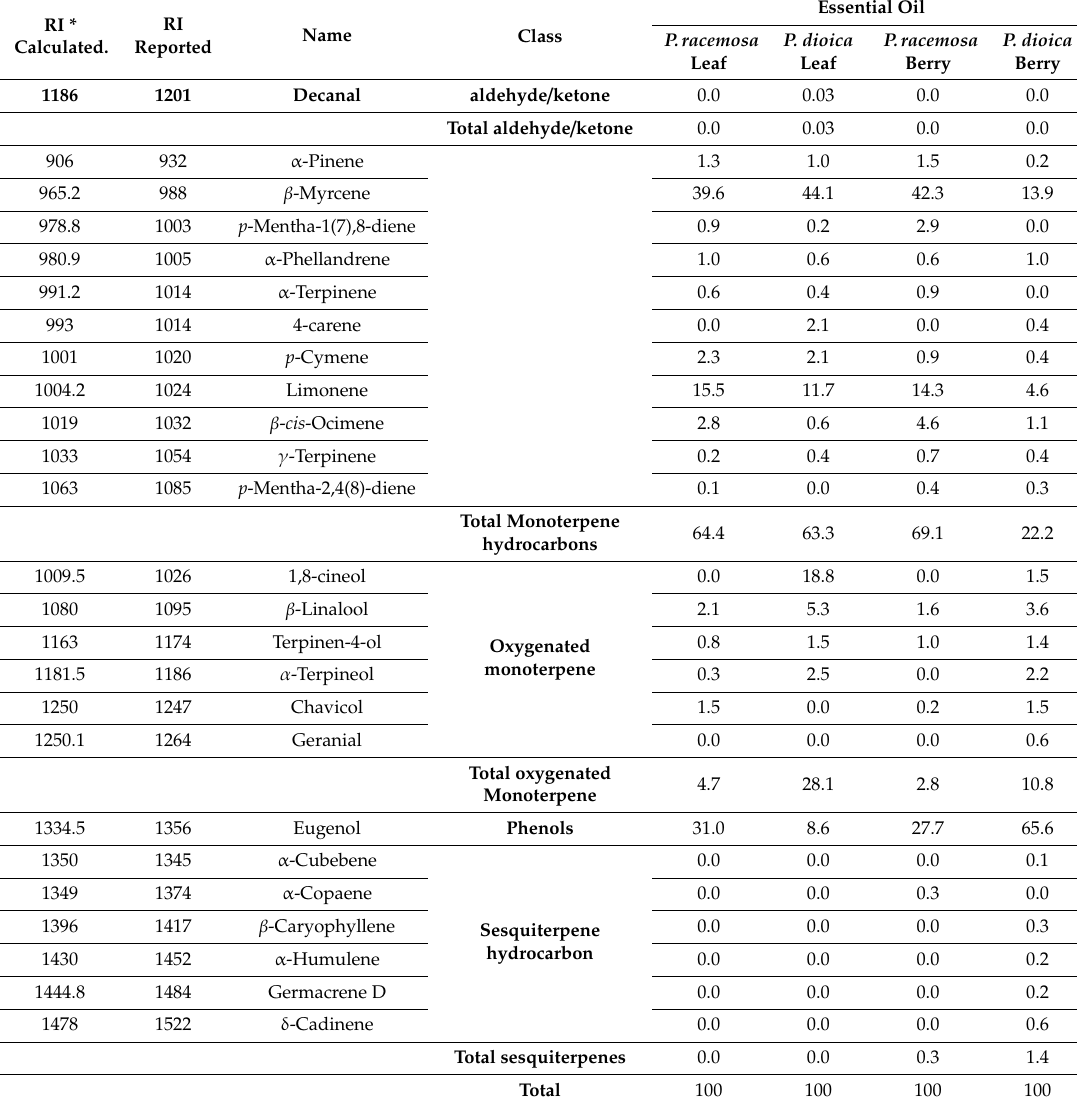
Table 3. Relative percentile levels of volatiles identified in Pimenta berry and leaf essential oils using GC / MS. RI *